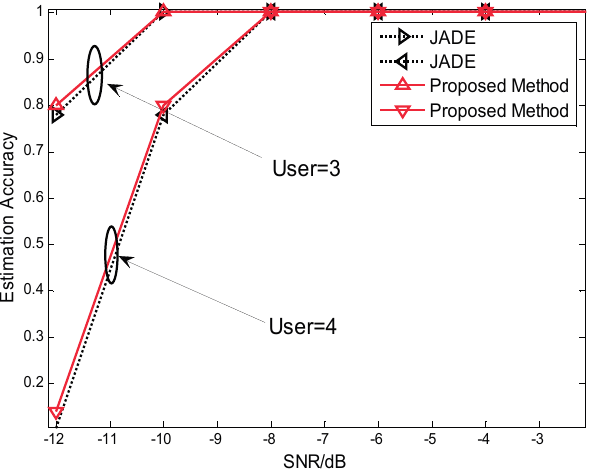
Figure 5. Performance of estimate the chip code for four users in a DS-CDMA system.